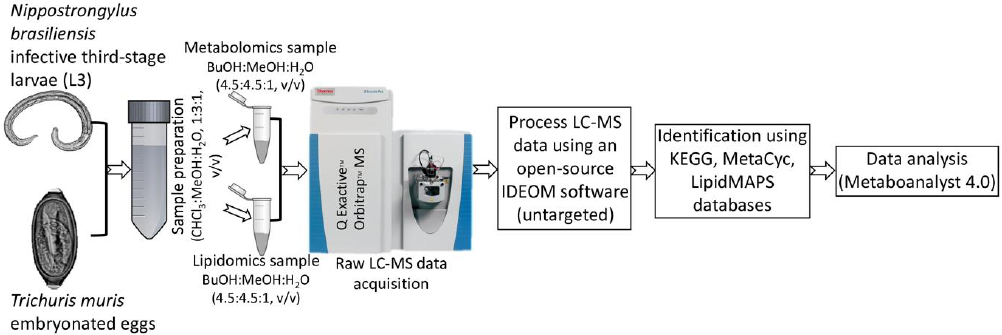
Figure 1. Schematic flowchart of the metabolomic and lipidomic profiling strategy applied for the infective stages of the N. brasiliensis (L3) and T. muris (embryonated A B